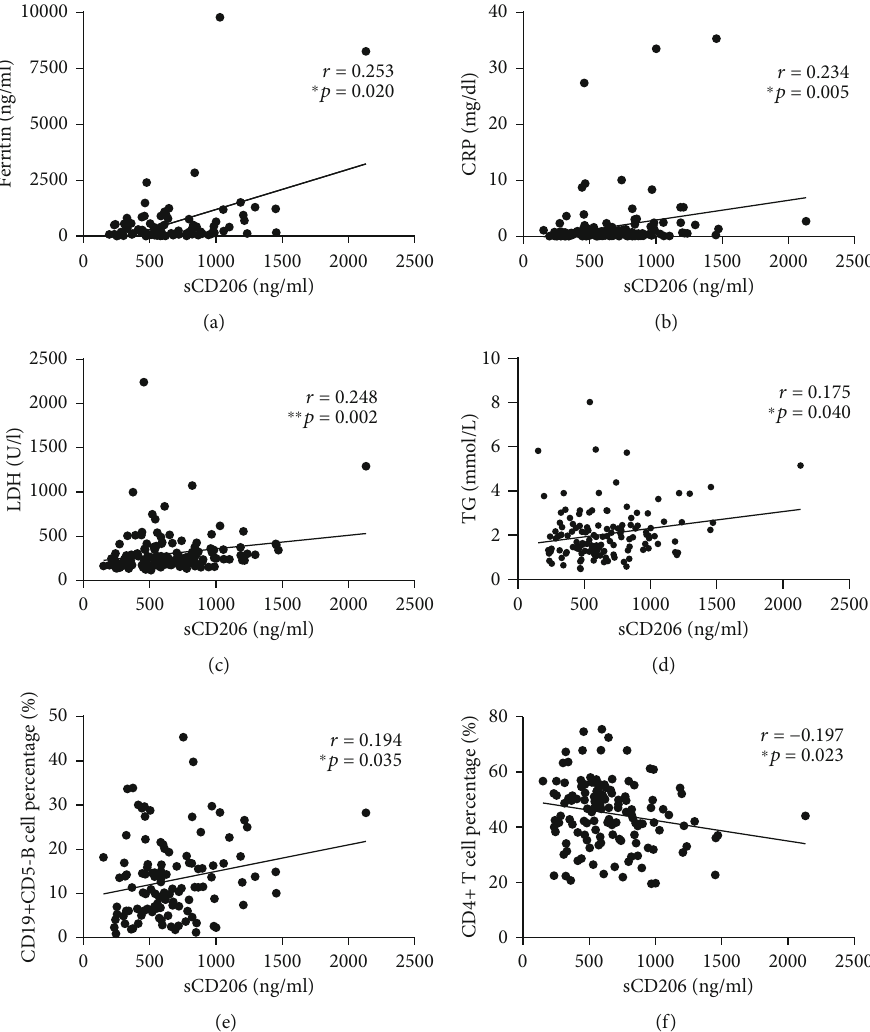
Figure 3: The correlations of sCD206 levels with laboratory parameters in patients with DM. (a) sCD206 levels were positively correlated with ferritin levels in patients with DM. (b) sCD206 levels were positively correlated with CRP levels in patients with DM. (c) sCD206 levels were positively correlated with LDH levels in patients with DM. (d) sCD206 levels were positively correlated with TG levels in patients with DM. (e) sCD206 levels were positively correlated with CD19+CD5- B cell percentage in patients with DM. (f) sCD206 levels were negatively correlated with CD4+T cell percentage in patients with DM. sCD206: soluble CD206; DM: dermatomyositis; CRP: C- reactive protein; LDH: lactate dehydrogenase; TG: